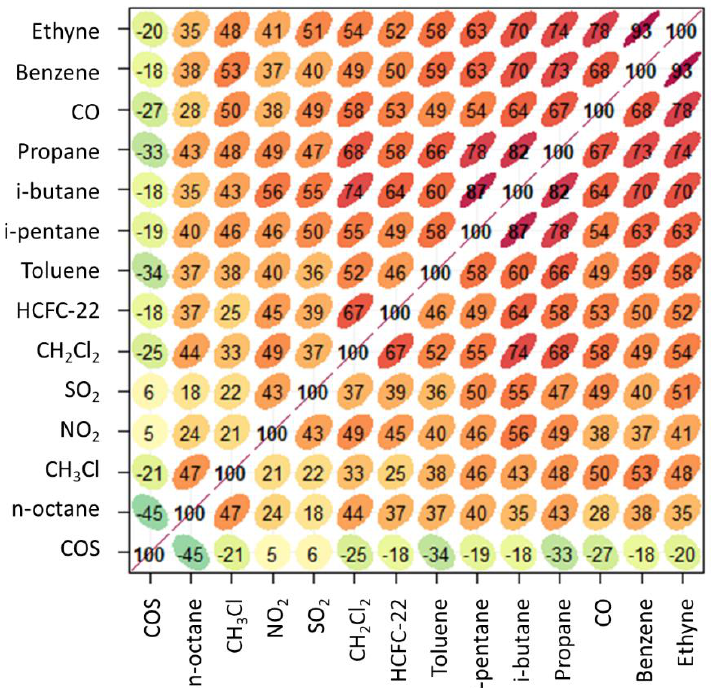
Figure 7. Multiple correlation analysis of the daytime dataset for summer 2017. The shape of ellipses provides a visual representation of the scatter plot for each couple of variables, the numbers and the colour code give representation of the R value (green: negative slope of correlation, red: positive slope of correlation).